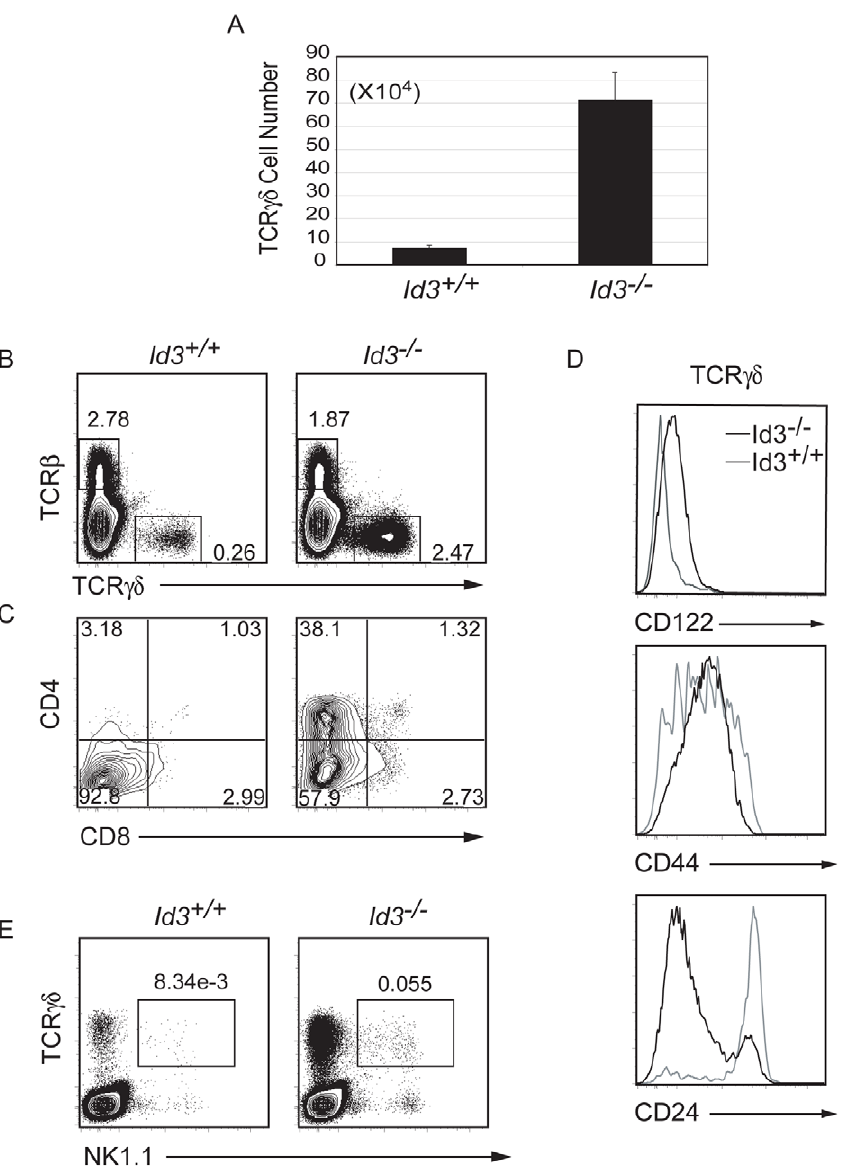
Figure 3. cd T cells with an activated phenotype are present in Id3 2 / 2 neonates. A) cd T cell numbers in Id3 + / + and Id3 2 / 2 mice analyzed 7 days after birth. Average + / 2 standard deviation is derived from 6 mice. p , 0.0005. B) TCR b and TCR cd expression on total thymocytes from 7 day